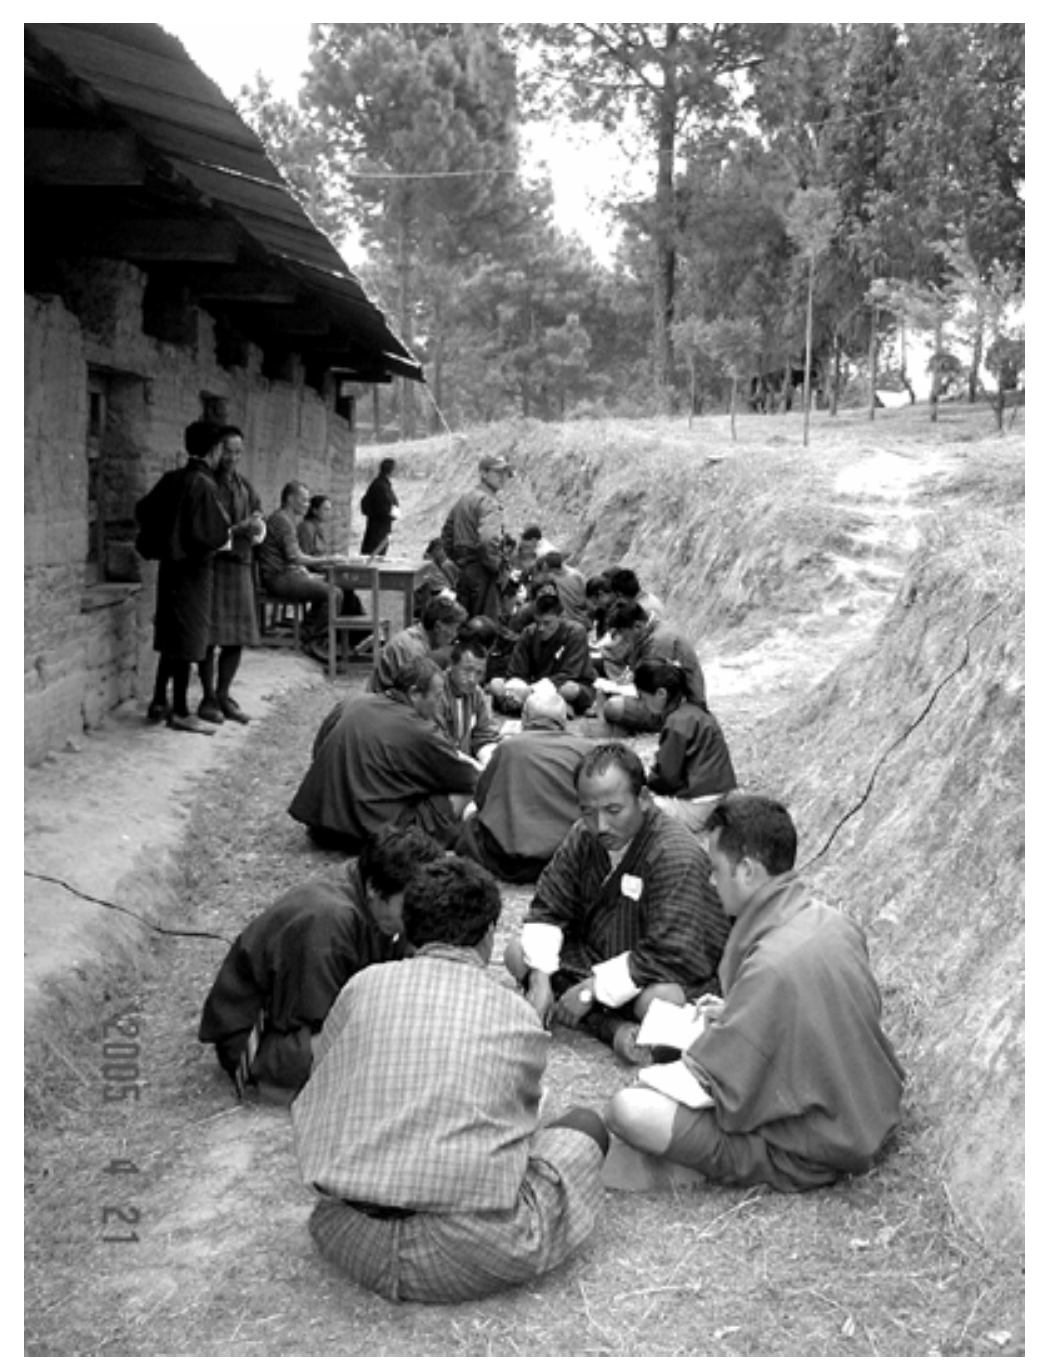
Fig. 8. Second RPG in